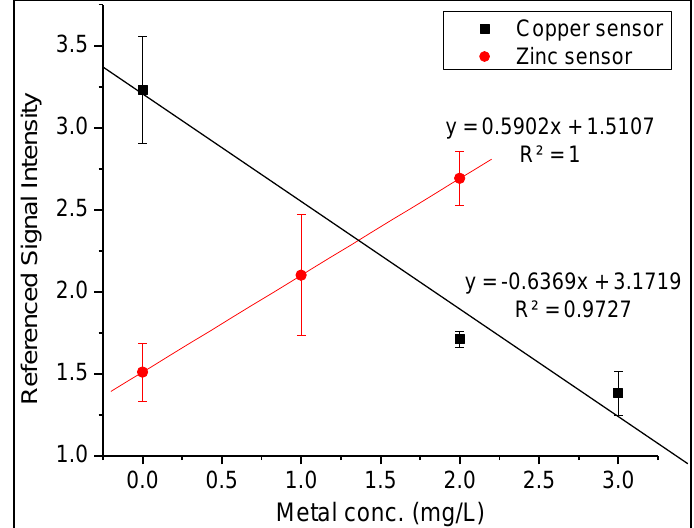
Figure 9. An analysis of solutions containing both copper and zinc in the same solution with the four sensor